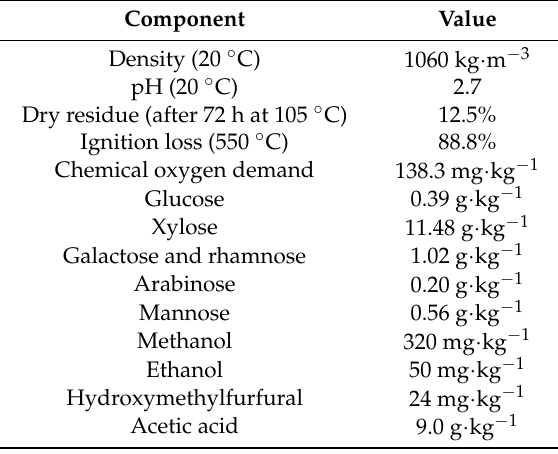
Table 2. The composition and the concentration of different spent sulfite liquors from different pulp mills can vary considerably depending on the raw materials and pulping conditions [11]. Table 2. Characterization of spent sulfite